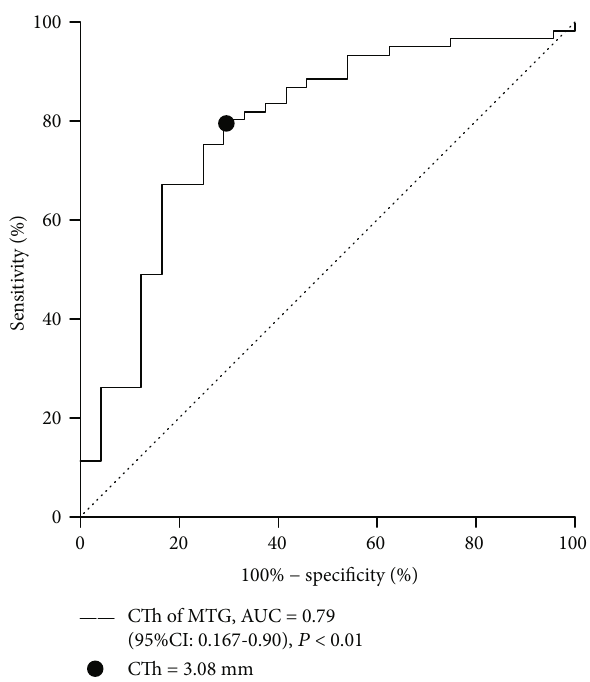
Figure 3: The ROC analysis showing the value of the CTh of right middle temporal gyrus (MTG) in di ff erentiating PD patients and healthy controls. The black dot indicates the cut-o ff point when sensitivity+speci fi city-1 reach the